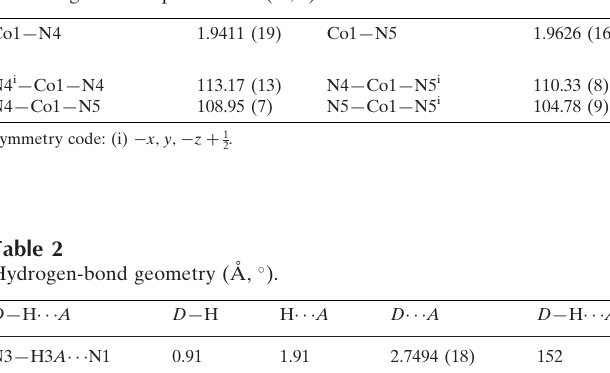
Selected geometric parameters (A˚ , (cid:3) ).